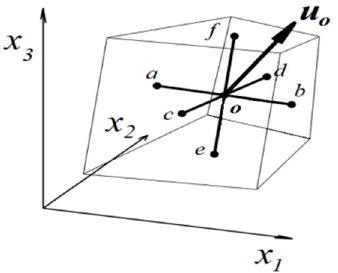
Figure 2. An arbitrary 3D element.